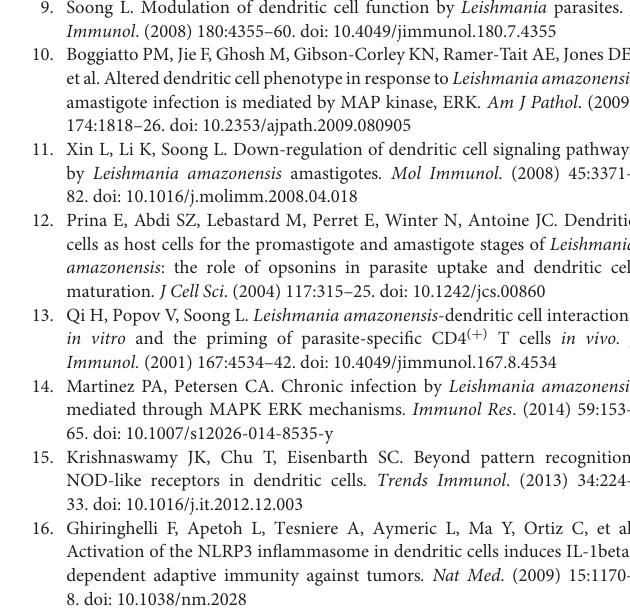
Supplementary Table 1 | List of transcription factors and co-regulators. Gene symbols are listed with their Ensembl reference and short description. Supplementary Table 2 | Partial list of GO gene sets highlighted in Leishmania -infected DCs. Gene-level results corresponding to 18 selected GO terms significantly ( p < 0.05) evidenced in DCs infected with Leishmania amazonensis amastigotes ( L. am and L. am -IS) are presented. The summary sheet describes the GO terms and their corresponding sheet (S2 to S19). For each GO term, genes are listed with their Entrez number, probe-set ID, Fold Changes (Log base 2) and adjusted p values for both L. am vs Ctrl and L. am -IS vs Ctrl comparisons. Color code indicates p values below the 5% threshold level. Supplementary Figure 1 | Evaluation of the maturation status of DC cultures by epifluorescence microscopy. BALB/c-derived BMDCs alone (Ctrl) or incubated for 24h with BCG (BCG) or L. amazonensis amastigotes without ( L. am ) or with Ab-opsonized ( L. am -IS) were subjected to epifluorescence microscopy imaging of MHC Class II and H2-M molecule staining. Representative DCs from the different conditions are displayed as merged images of the 3 detection channels showing MHC II molecules (green), H2-M molecules (red), and nuclear DNA (blue). Supplementary Figure 2 | Influence of the γ chain subunit of FcgammaRI, FcgammaRIII, and Fcepsilon RI receptors on the phenotype of DC cultures. (A) Flow cytometric comparison of surface marker expression of BMDCs from wild type mice from Charles River (CR) and Taconic (Tac) laboratories. Histograms show the mean fluorescence intensity of the indicated markers. Numbers represent the percentage of DCs expressing the corresponding marker. Note the similarity of the profiles between both sources of BALB/c mice. (B) Phenotypic analysis of DCs derived from wild type (gray histograms) and Fc γ − / − (black histograms) mice from Taconic laboratories. DCs alone (Ctrl) or incubated for 24h